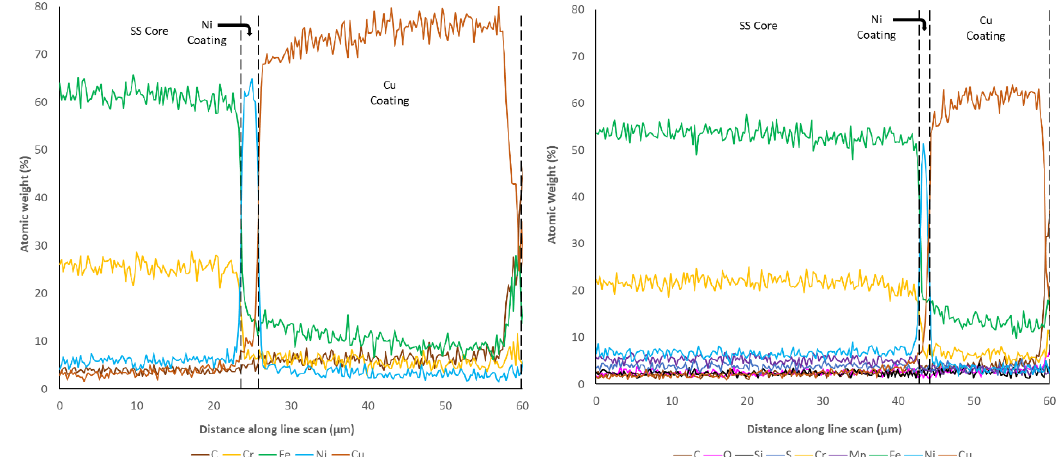
Figure 19. Element atomic weight distribution for the SS Ni + Cu thin-walled pipe ( left , 8) and thick-walled pipe ( right , 9)